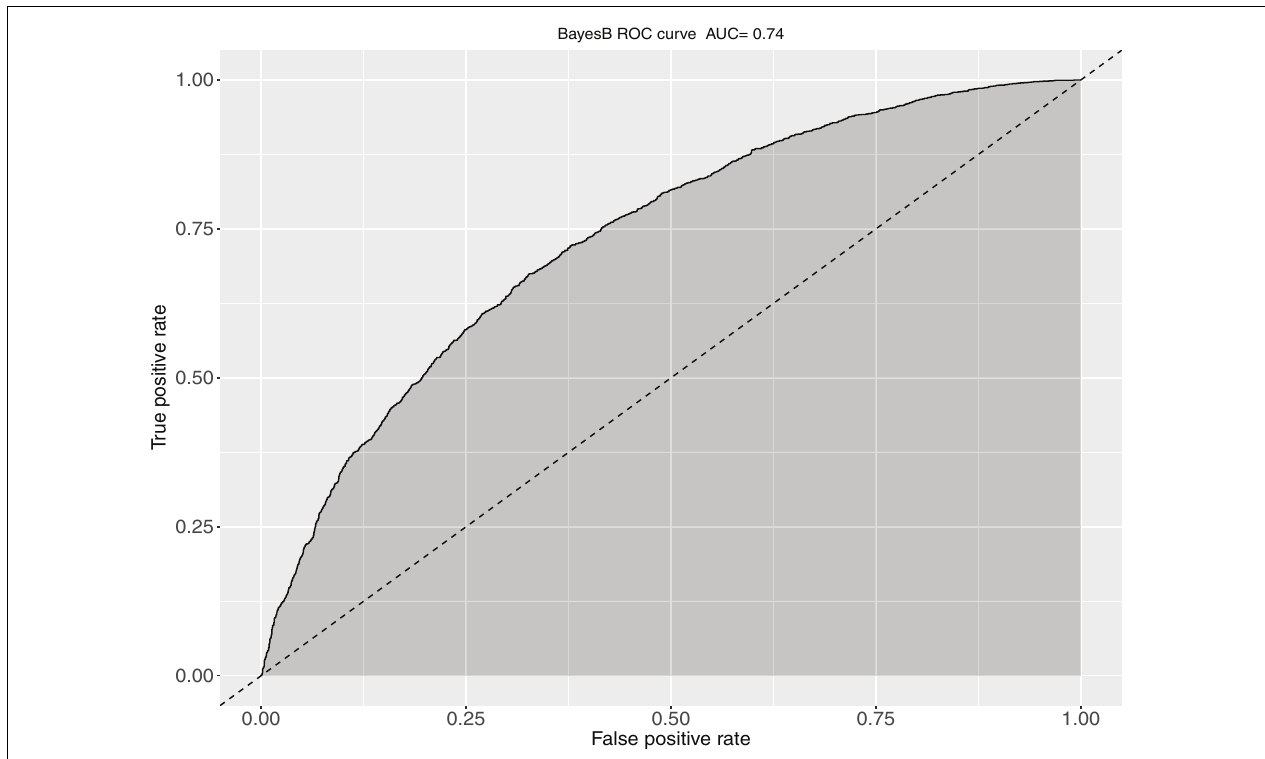
FIGURE 3 | The ROC curve and corresponding AUC metrics for BayesB-based predictions of KHV survival. The plot was obtained from aggregation of a 5-fold cross validation scheme when full sibs existed in the training set for every animal of the validation